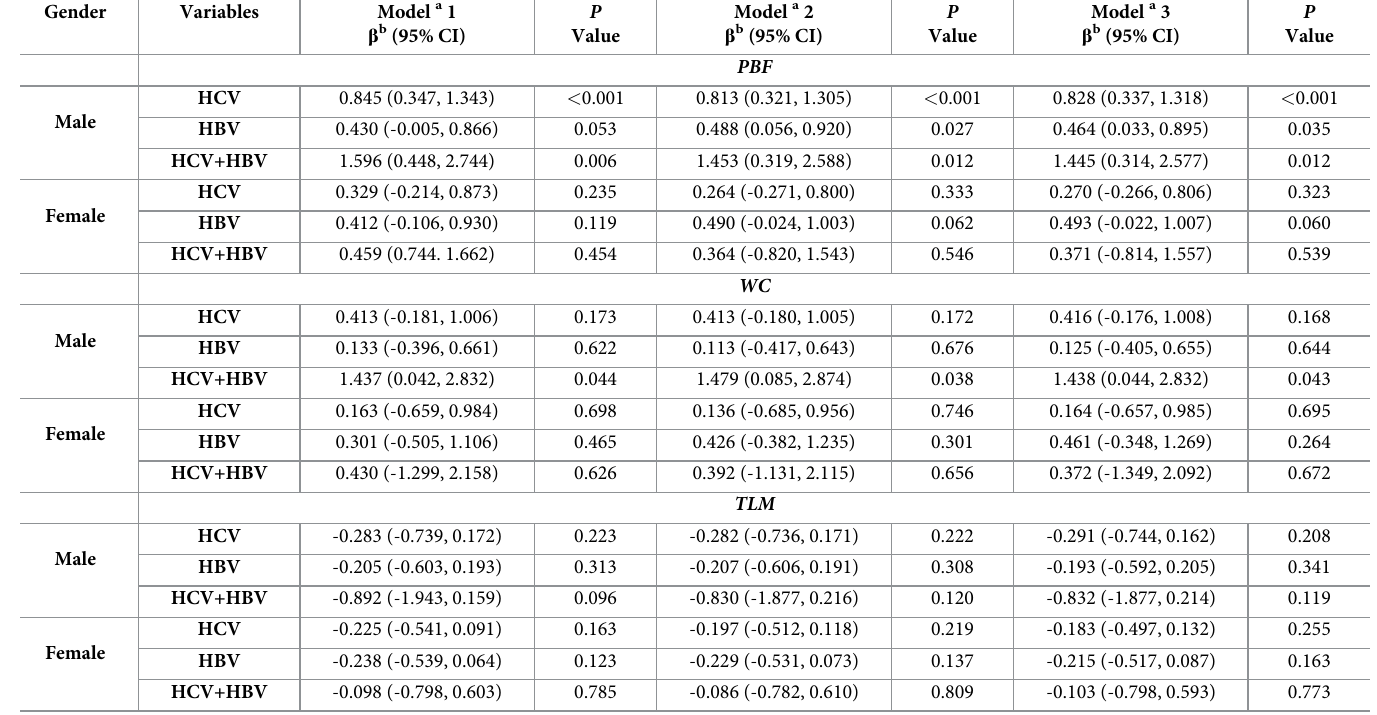
Table 3. Association between hepatic infection and anthropometric parameters in gender